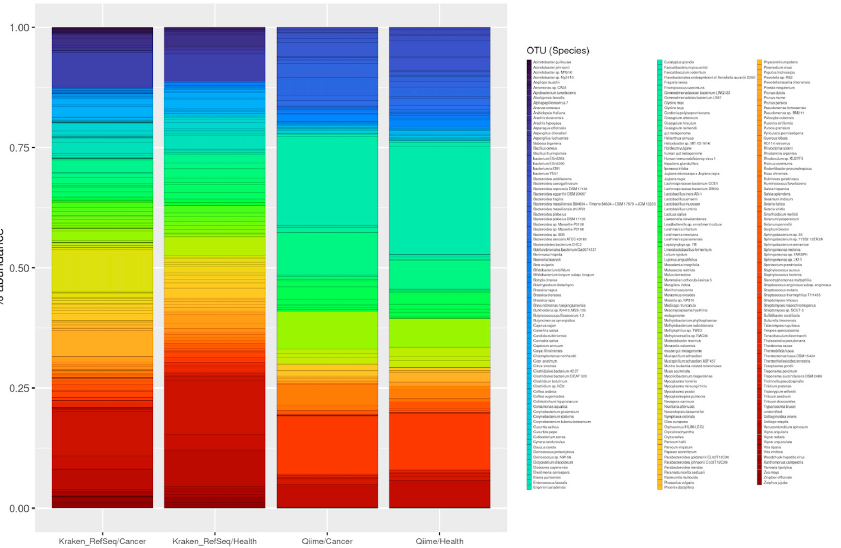
Figure 12 . Number of species identified for tumour/healthy samples by the Kraken/Bracken (in RNA-Seq) and the QIIME2 (in 16S) pipelines. Barplot showing the number of microorganism species detected by the Kraken/Bracken pipeline (using RefSeq database) and the QIIME2 pipeline (using SILVA) in an endometrial cancer study by Li C. et al. The list of OTUs in the legend is included in Supplementary Table